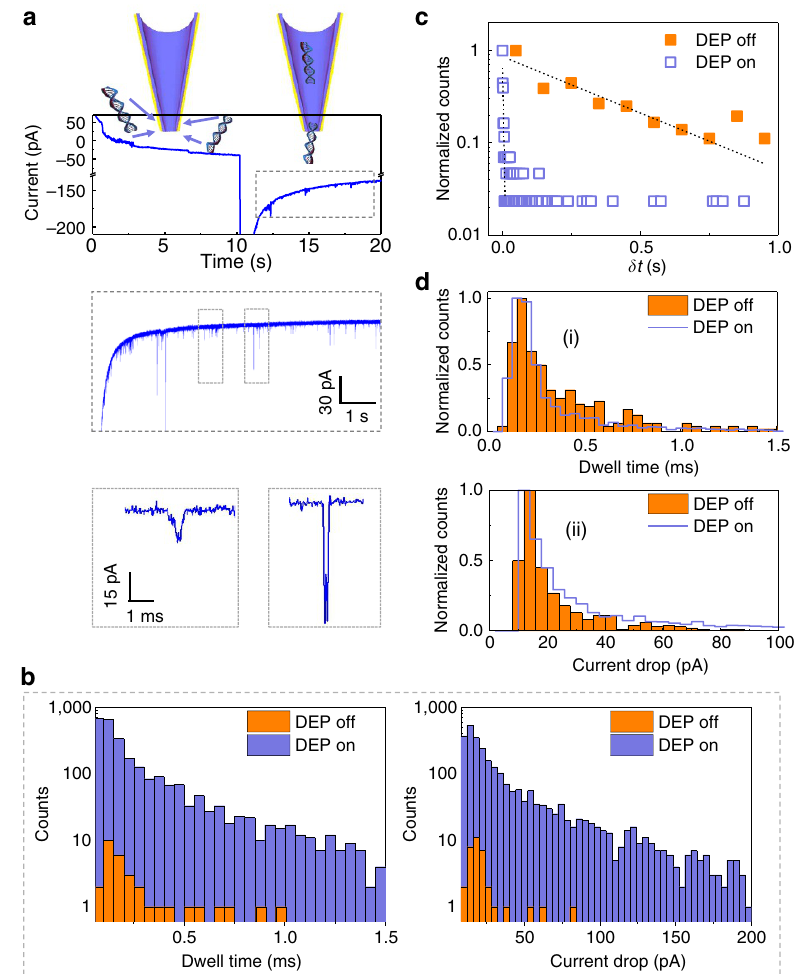
Figure 4 | Single-molecule detection and analysis with and without DEP. ( a ) Current traces of a typical DEP pre-concentration/recording cycle with various time scaling. The first 10s is the pre-concentration phase and the later 10s is the translocation/detection phase. The lower panel shows typical events representing a single DNA molecule translocation ( B 96% of events), as well as a DNA aggregate translocating the pore ( B 4% of events; see Supplementary Note 7 and Supplementary Figs 13 and 14). ( b ) Time-normalized histogram of the dwell time and current drop comparing translocations with and without DEP pre-concentration. ( c ) Normalized histogram of the inter-event time ( d t ) with and without DEP pre-concentration. ( d ) Count- normalized distributions with and without DEP pre-concentration for the dwell time (i) and current drop (ii). All DEP data were obtained at V pp ¼ 12V, f AC ¼ 1MHz and d gap ¼ 50 m